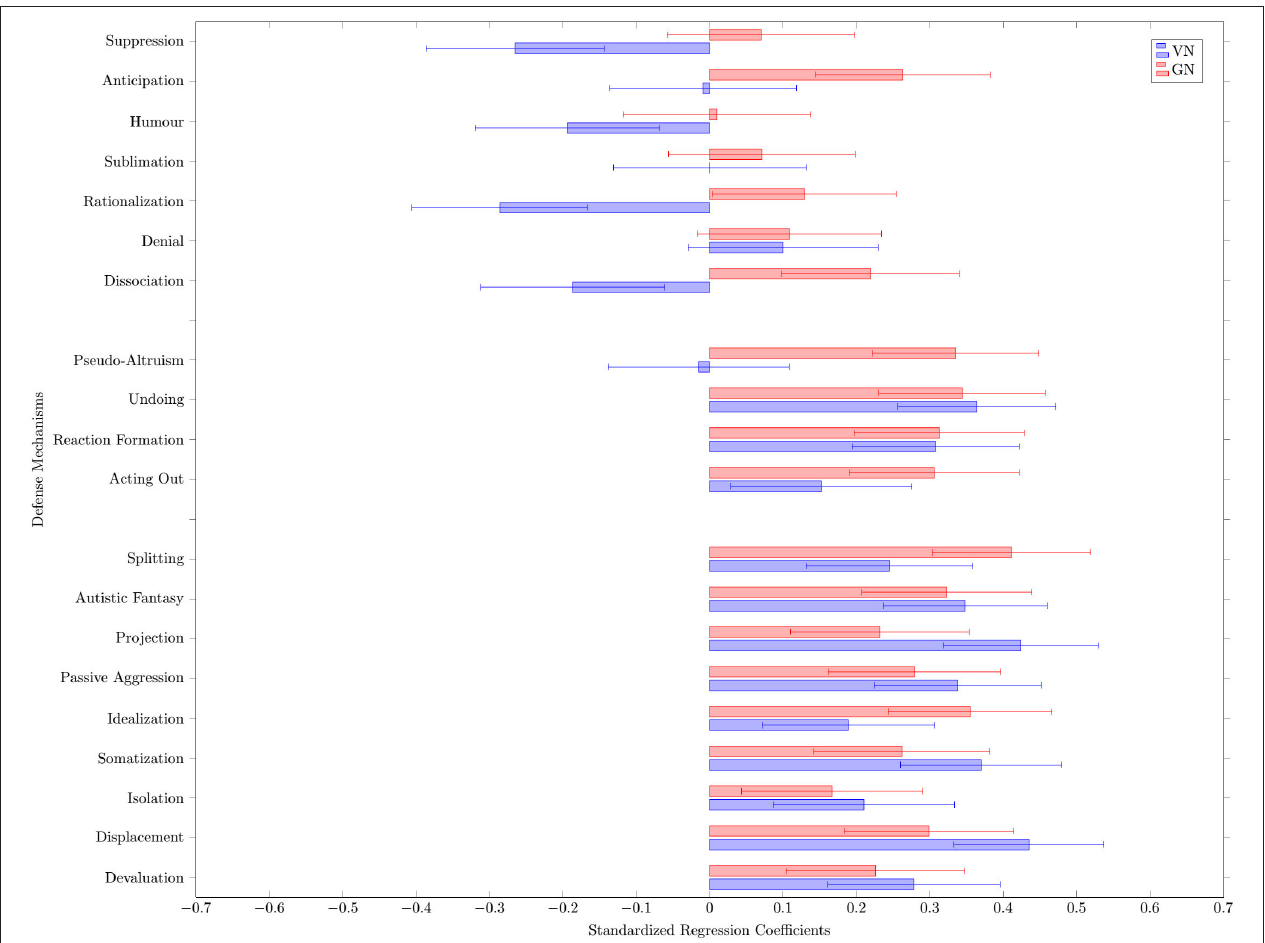
FIGURE 2 | Influence of grandiose and vulnerable narcissism on defense mechanisms: standardized regression coefficients and their confidence